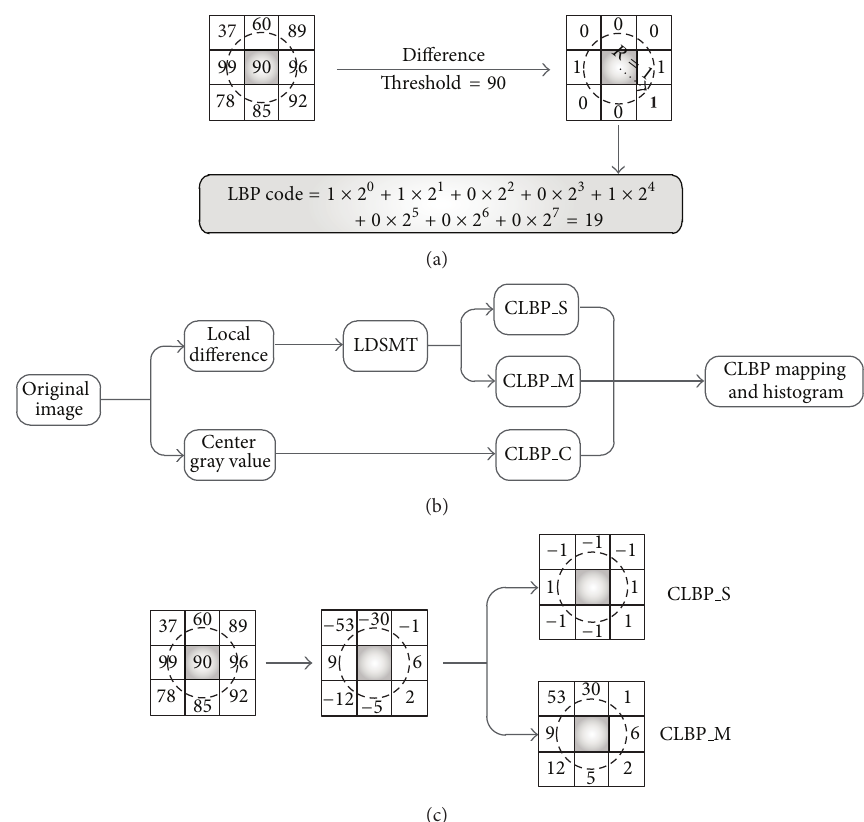
Figure 1: Illustrations of how to calculate LBP and CLBP features for an 8-neighborhood pixels. (a) The standard LBP operator (see (1)). (b) The framework of CLBP operator (see, (3) and (5)). (c) Example to obtain sign and magnitude pattern component from CLPB (see (1) and